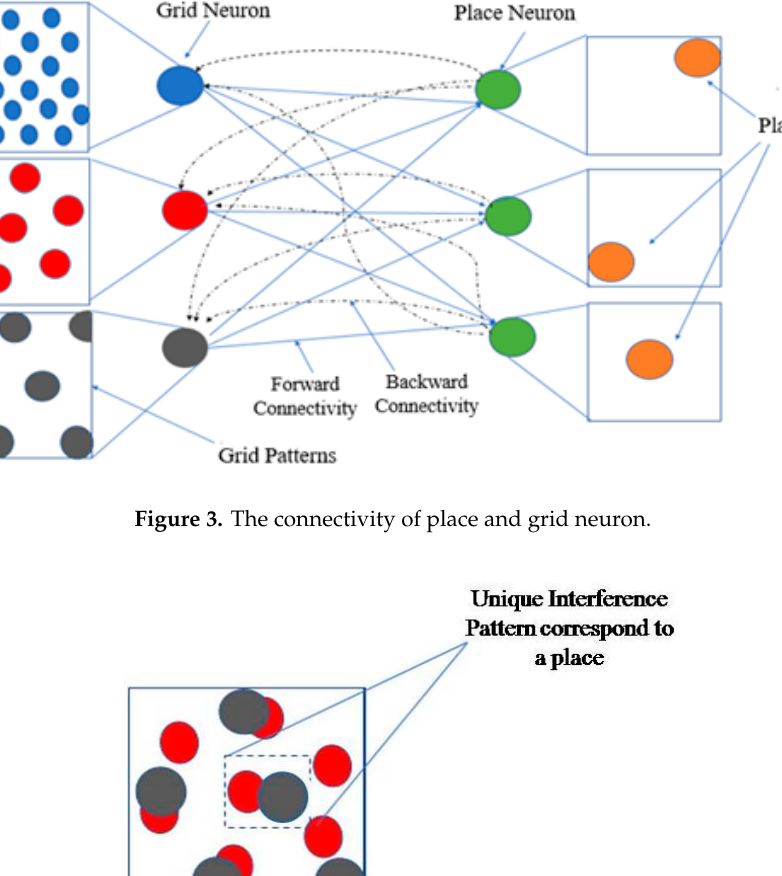
Figure 4. Localization using overlapped grid patterns.